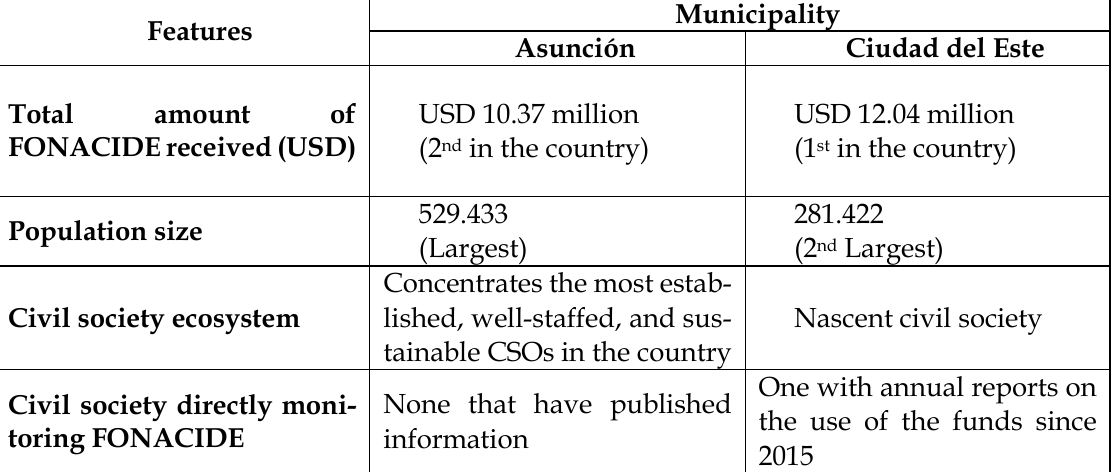
Table 4: Comparison between Asuncion and Ciudad del Este